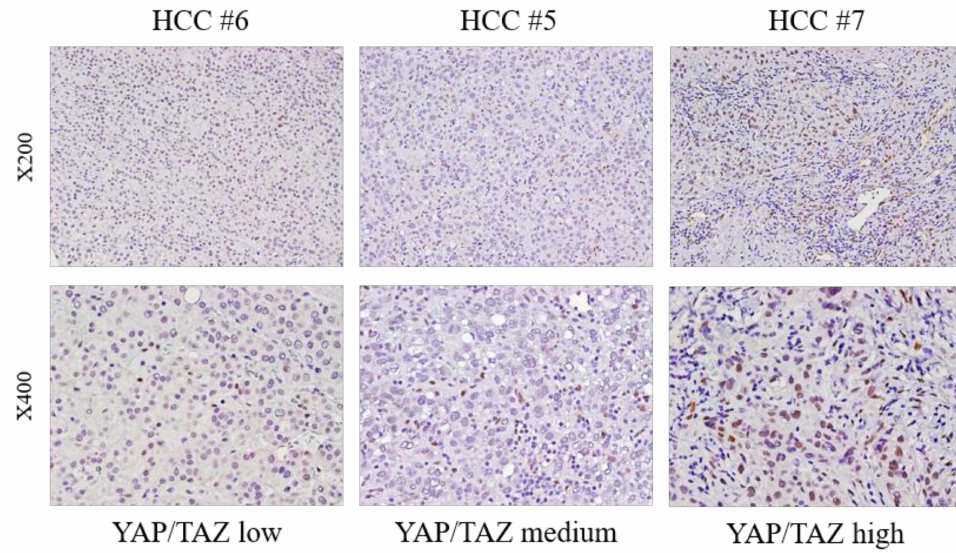
Figure 3. Comparison of YAP/TAZ expression among different primary HCC tissue. Immunohis- tochemical expression of YAP/TAZ in tissues from HCC patients. Yellowish staining of nucleus demonstrates positive immunostaining of YAP/TAZ. YAP/TAZ positivity was assessed according to the number of positively stained cells: score 0 (<5%), score 1 (6–25%), score 2 (26–50%), score 3 (51–75%), score 4 (>75%). HCC #7 presented with YAP/TAZ score 3 (high), whereas HCC #5 and HCC #6 showed YAP/TAZ score 1 and score 0 respectively. Representative images were taken under a microscope ( × 200: first row; × 400: second